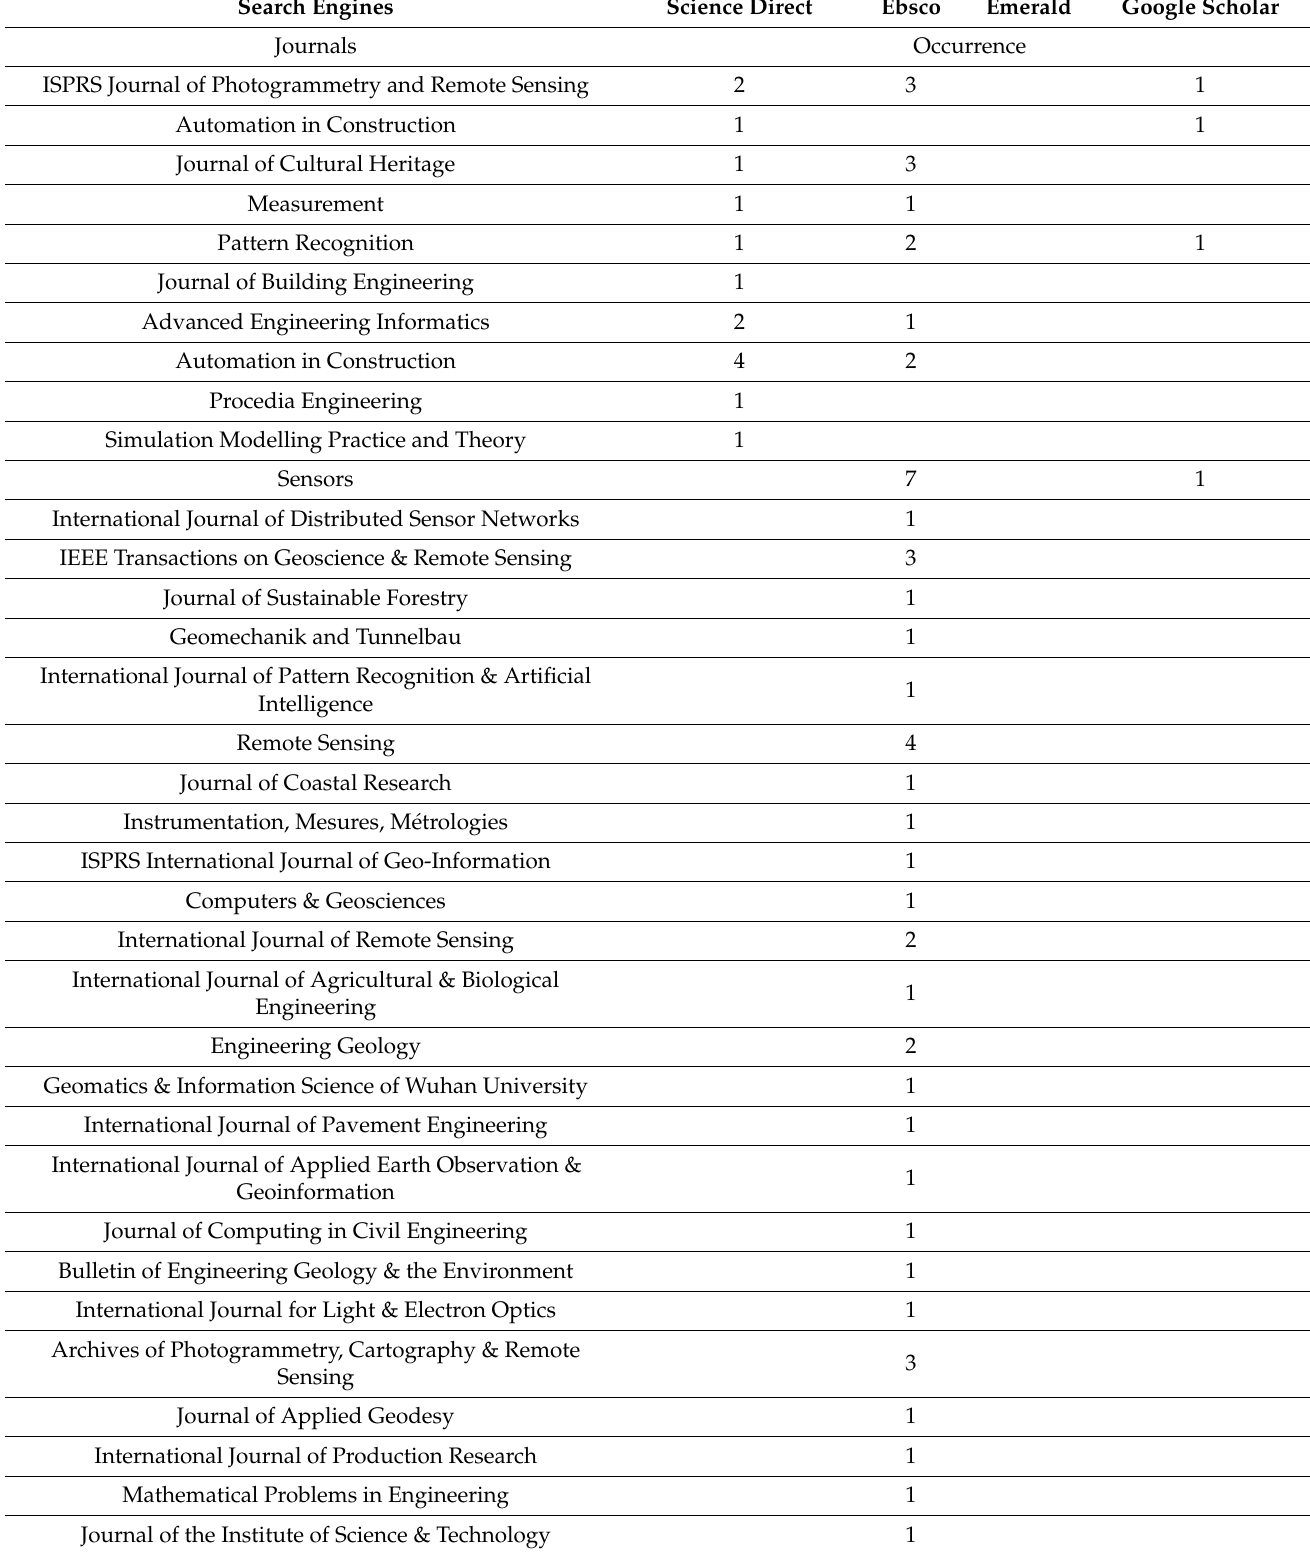
Table 1. “3D Laser Scanning” + “Point Clouds”